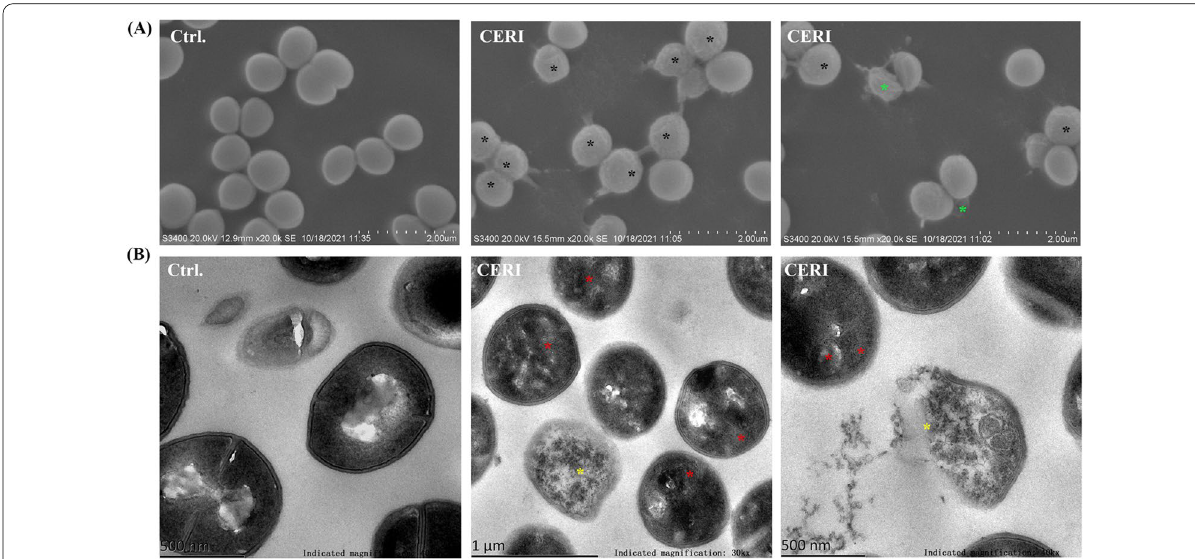
Fig. 2 Membrane disruption of CERI by SEM and TEM observation. S. aureus ATCC 43300 was treated with 32 μg/mL CERI for 1 h. A SEM showed shrinkage (black star) and collapse in the terminal stage (green star). Scale bars, 2 μm. B TEM showed mesosome-like structures (red star), cell membrane damage and cell lysis (yellow star). Scale bars, 500 nm (left and right) and 1 μm